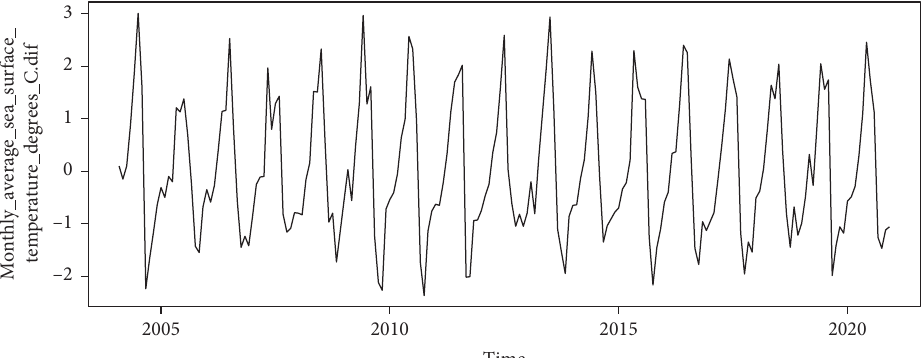
Figure 7: The time series diagram of the seawater temperature data of region 15 after first-order difference.